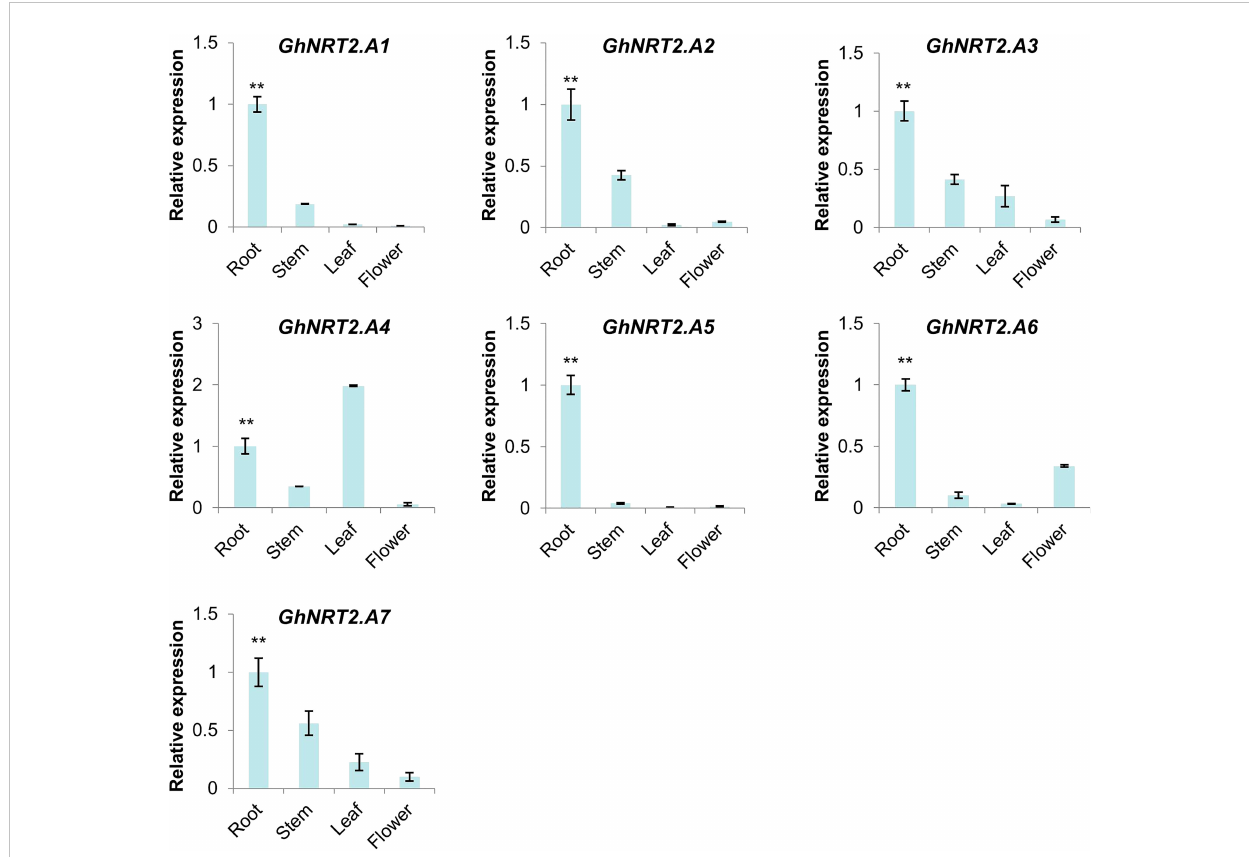
FIGURE 7 The expression of GhNRT2.A1-A7 in different organ. The qRT-PCR result of GhNRT2.A1-A7 in root, stem, leaf, and fl ower of G.hirsutum . Values represent the mean ± S.D (n = 3 replicates). **p< 0.01, Dunn ’ s